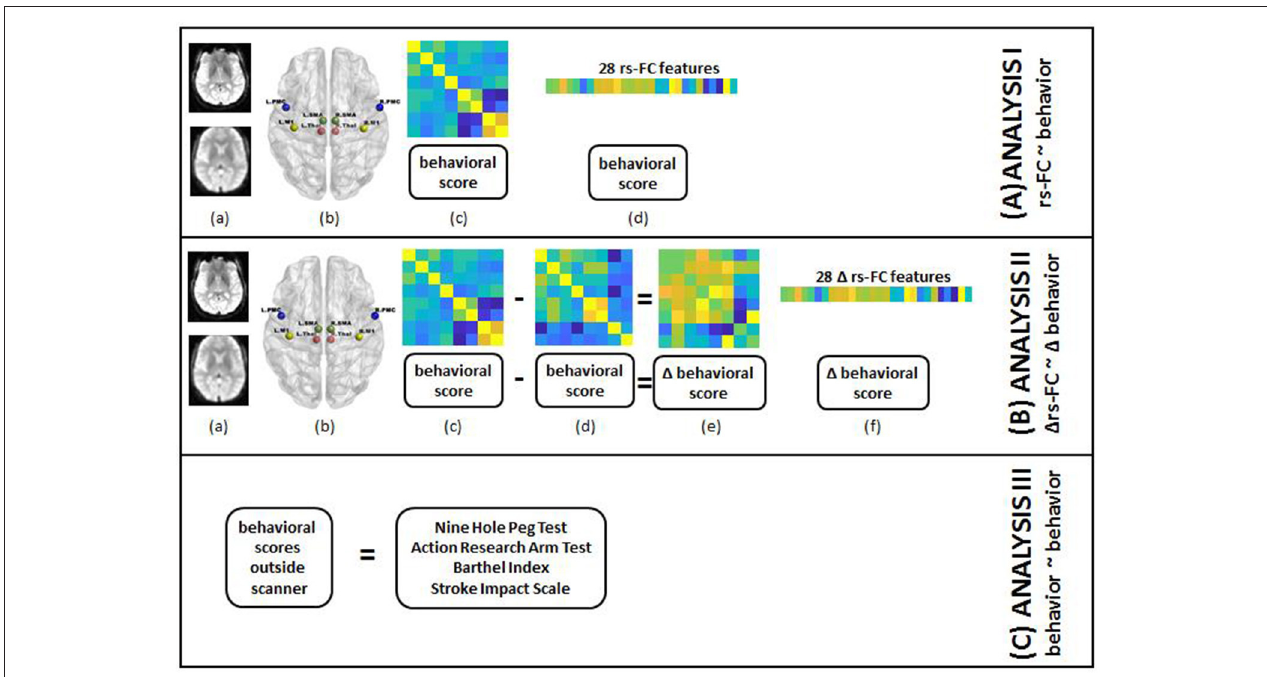
FIGURE 2 | Steps for individual subject analysis are shown below. (A) rs-FC correlates of behavior: (a) raw rs-fMRI (top) from pre-, post- and 1-month post-interventions were preprocessed (bottom); (b) 8 seed regions were chosen from the motor network to compute rs-FC at each time-point; (c) 8 × 8 rs-FC matrix was computed and corresponding behavioral scores were transformed as needed for each time-point; (d) rs-FC reflected in the lower triangle of 8 × 8 matrix was vectorized into 28 unique correlation coefficients per subject and 8 distinct behavioral measures were aggregated for group-level analysis. (B) 1 rs-FC correlates of 1 behavior: (a) raw rs-fMRI (top) from pre-, post- and 1-month post-interventions were preprocessed (bottom); (b) 8 seed regions were chosen from the motor network to compute rs-FC at each time-point; (c) 8 × 8 rs-FC matrix was computed and corresponding behavioral scores were transformed as needed for a preceding time-point; (d) 8 × 8 rs-FC matrix was computed and corresponding behavioral scores were transformed as needed for a succeeding time-point; (e) change in rs-FC and behavioral scores were calculated between the two time-points; (f) change in rs-FC reflected in the lower triangle of 8 × 8 matrix was vectorized into 28 unique correlation coefficients per subject and change in 8 distinct behavioral measures were aggregated for group-level analysis. (C) behavioral correlates at preceding time-point of behavior at succeeding time-point: transformed scores for 8 behavioral measures at pre-, post- and 1-month post-interventions were aggregated for group-level analysis.